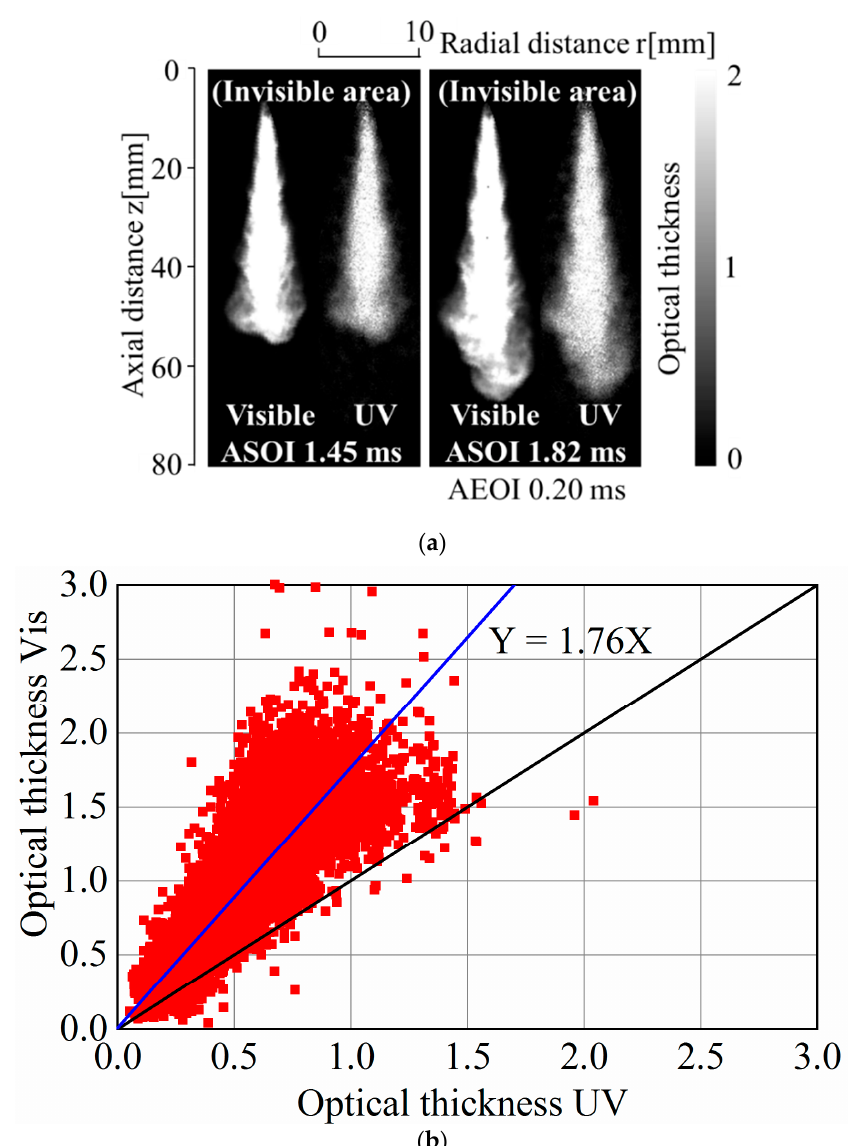
Figure 4. Non evaporating spray image and line-of-sight optical thickness of UV vs. visible light (T a = 300 K, P a = 1.8 MPa, P inj = 100 MPa, M f = 5.0 mg). ( a ) Non-evaporating spray images. ( b ) Line-of-sight optical thickness.